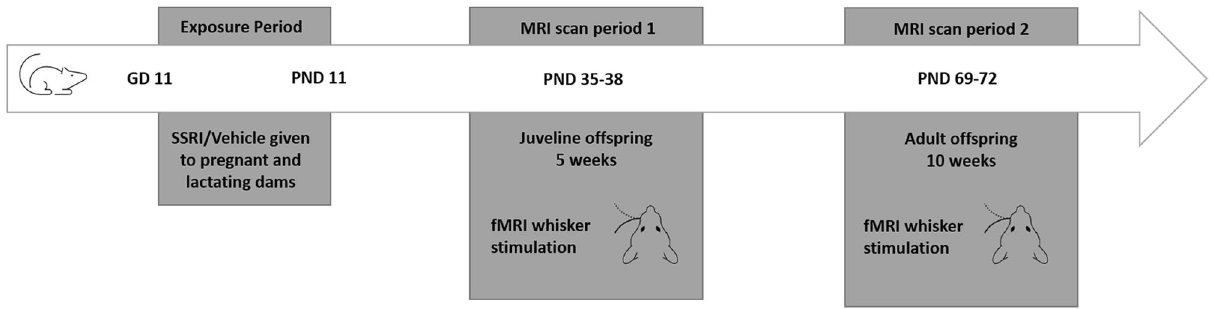
Figure 1. Model of the experimental timeline and set-up. GD gestational days, PND postnatal